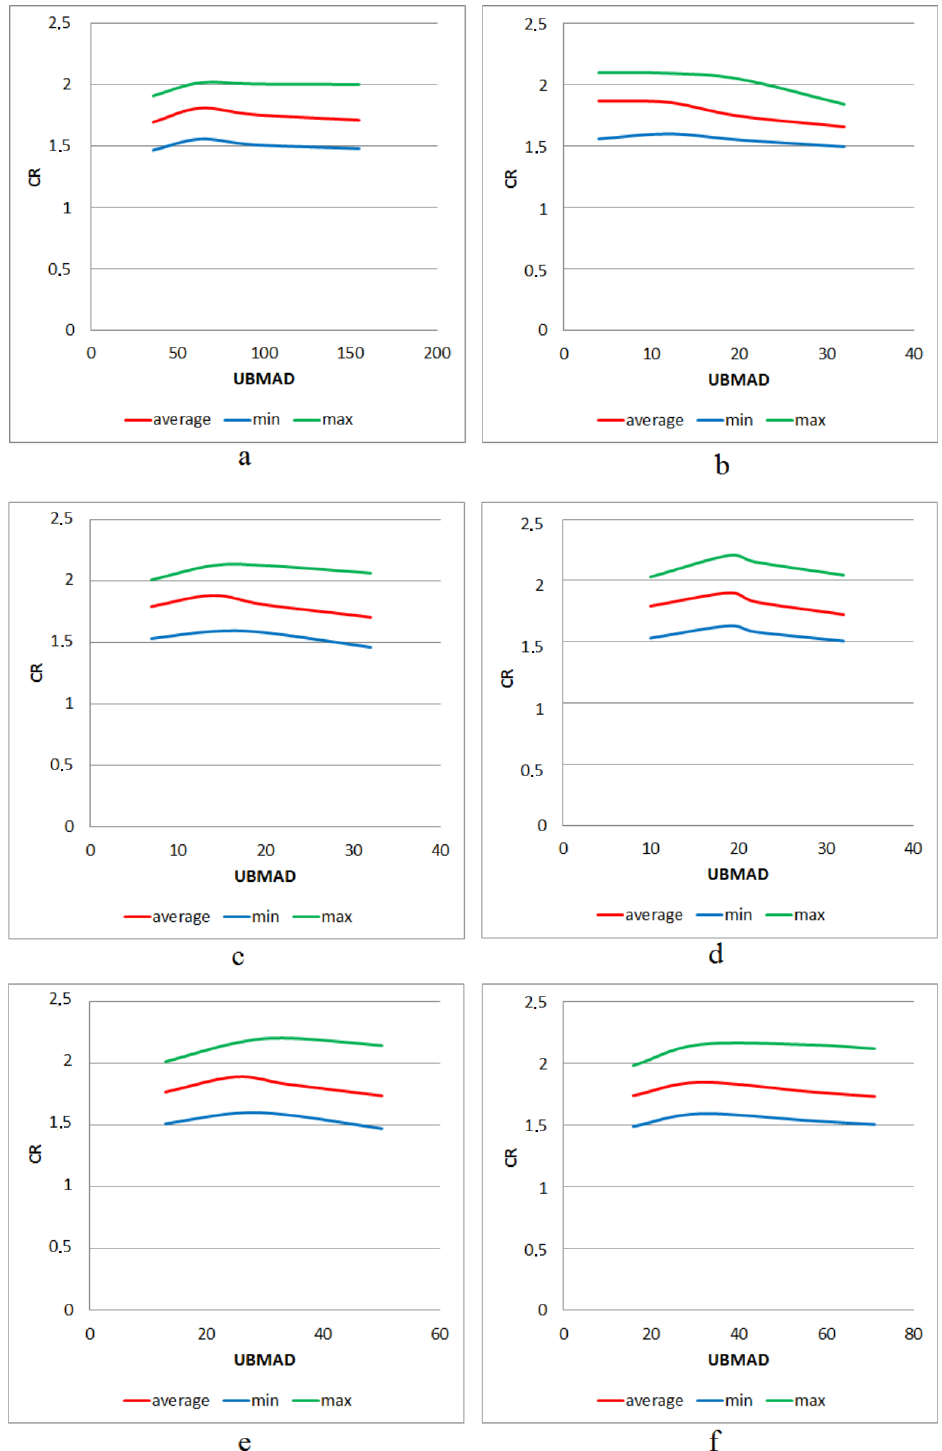
Figure 14. Dependence of the minimum, maximum, and average values of CR on UBMAD for different structures of the procedure DAT: DAT1 of depth 5 ( a ); DAT2 of depth 1 ( b ); DAT2 of depth 2 ( c ); DAT2 of depth 3 ( d ); DAT2 of depth 4 ( e ); DAT2 of depth 5 ( f ).